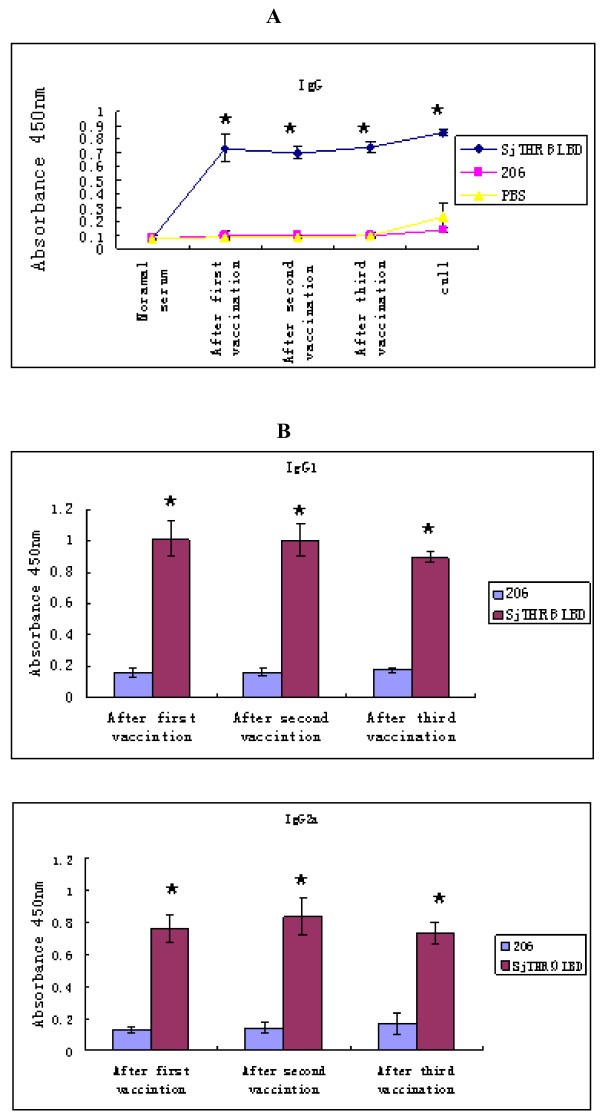
A Detection of specific IgG antibody against rSjTHRβ-LBD by ELISA. Mice were injected with rSjTHRβ-LBD, 206 adjuvant and PBS, respectively. Figure 7B Detection of specific IgG1 and IgG2a antibodies against rSjTHRβ-LBD. This result was obtained by three replicates with identical protocols. Vertical bars depict the ± SD about the mean. The asterisks (*) indicate significantly increased serum antibody titers compared with that of the 206 control (P < 0.01).